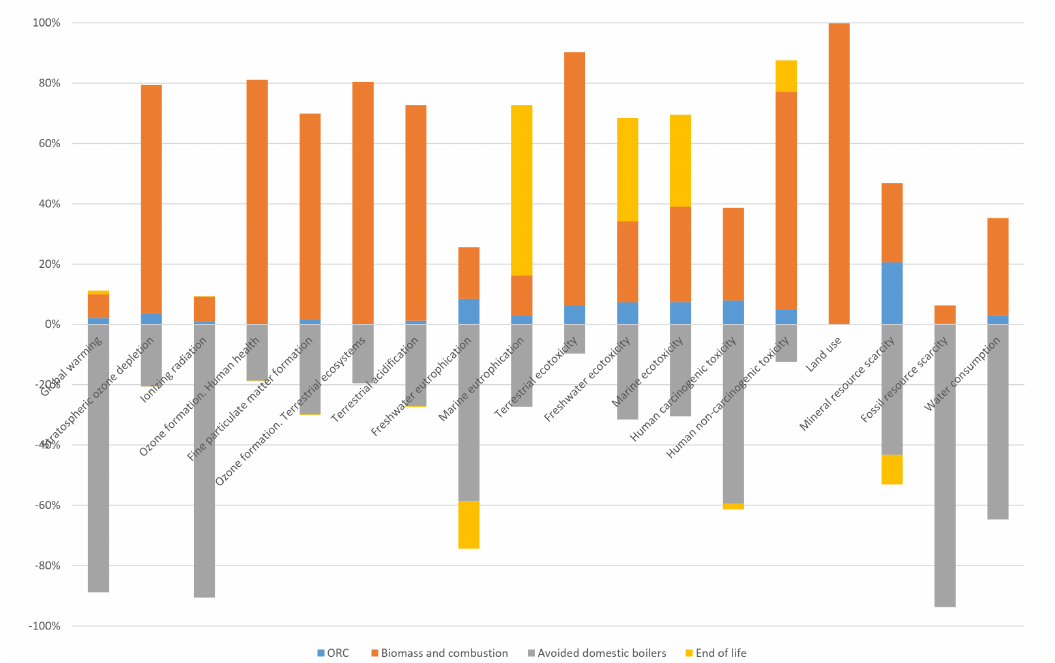
Figure 6. Contribution of the different operations to the overall impact in CHP mode. Results are obtained with ReCiPe 2016—Midpoint (H)